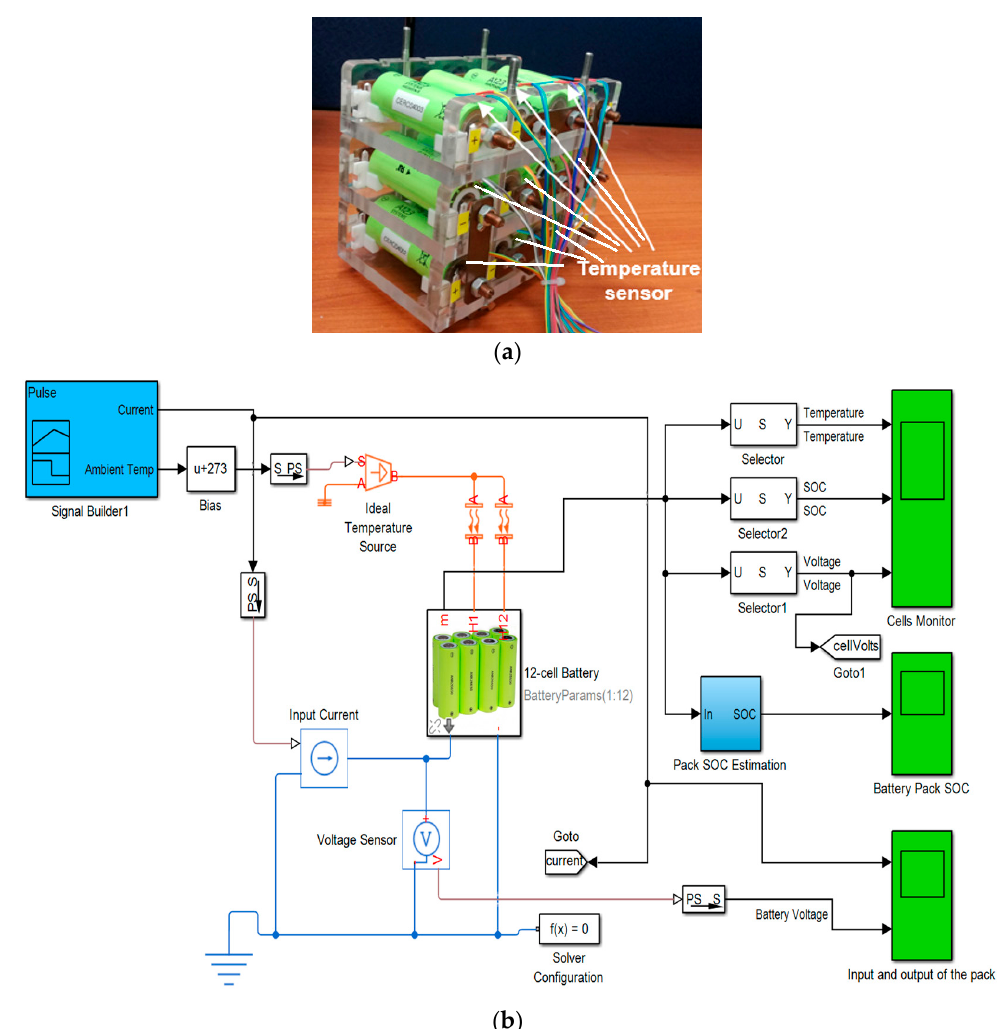
Figure 7. ( a ) Actual 12-cell battery prototype with temperature sensor placed at top surface of each cell; ( b ) simulation model of 12-cell battery in Simscape [67]. Table 6. RMSE for SOC estimated in different cells.